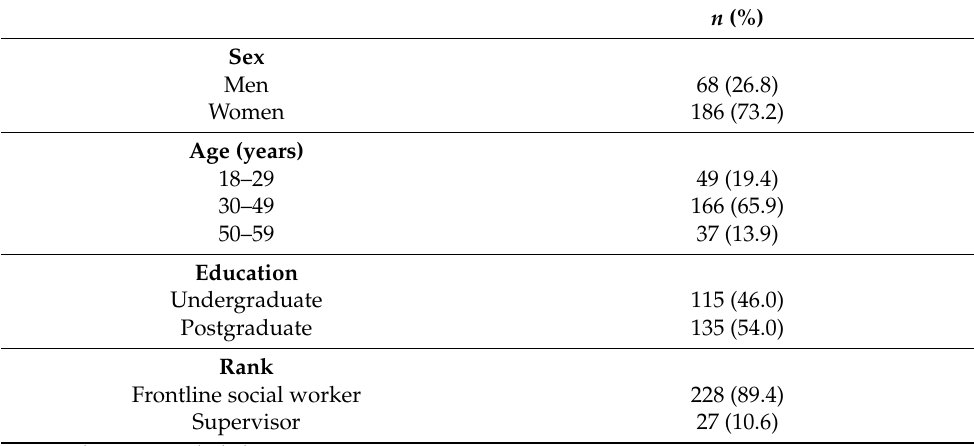
Table 2. Characteristics of respondents ( n = 255).